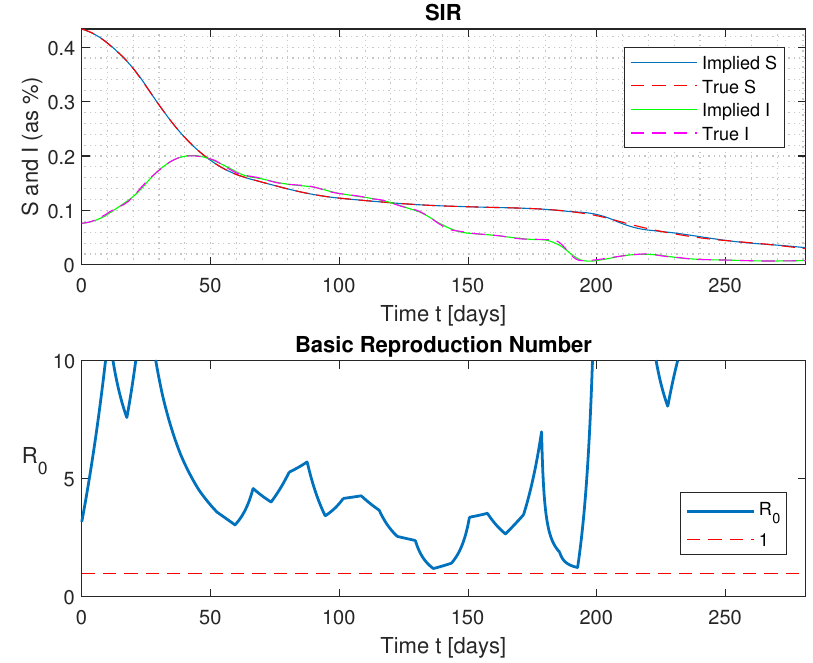
Figure 12. Recovered and observed susceptible S and infected I population ( top ) and the basic reproduction number R 0 ( bottom ) for α =